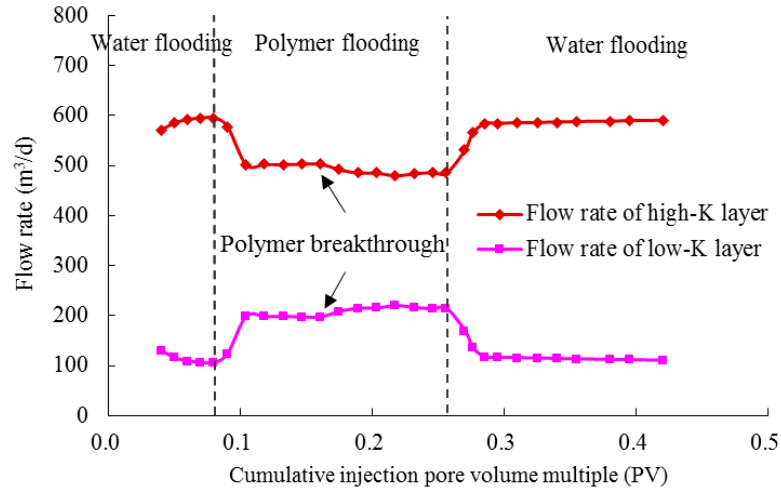
Figure 8. Change law of the zonal flow rate at different stages.